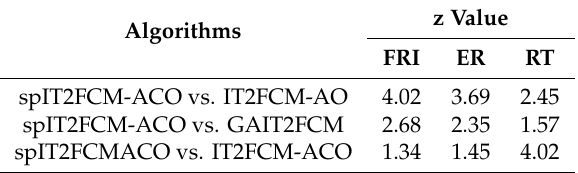
Table 10. Evaluation of performance di ff erence between spIT2FCM-ACO and other